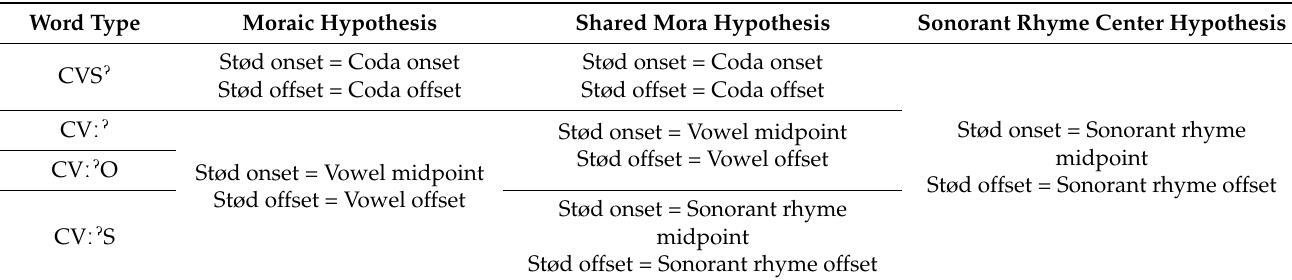
Table 3. Predictions of the moraic hypothesis, shared mora hypothesis, and sonorant rhyme center hypothesis on stød timing across word types. Cells are combined across rows if the hypothesis makes the same predictions about various word types.